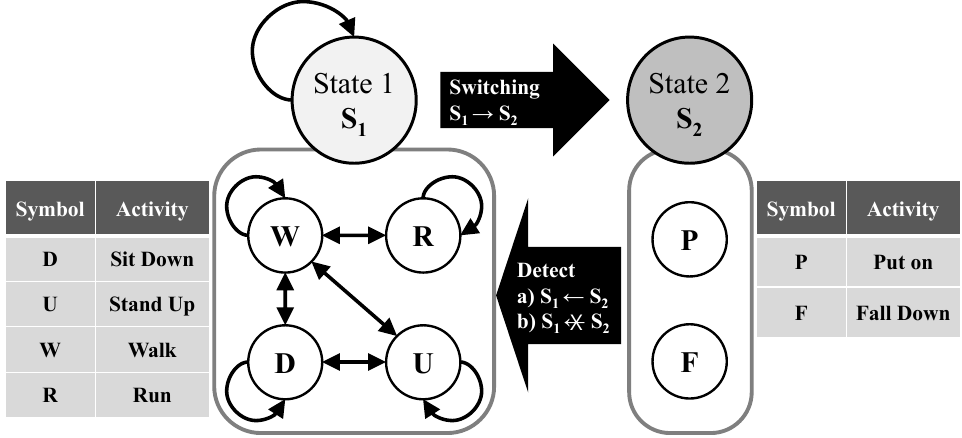
Figure 7. State switching to detect mobile-person